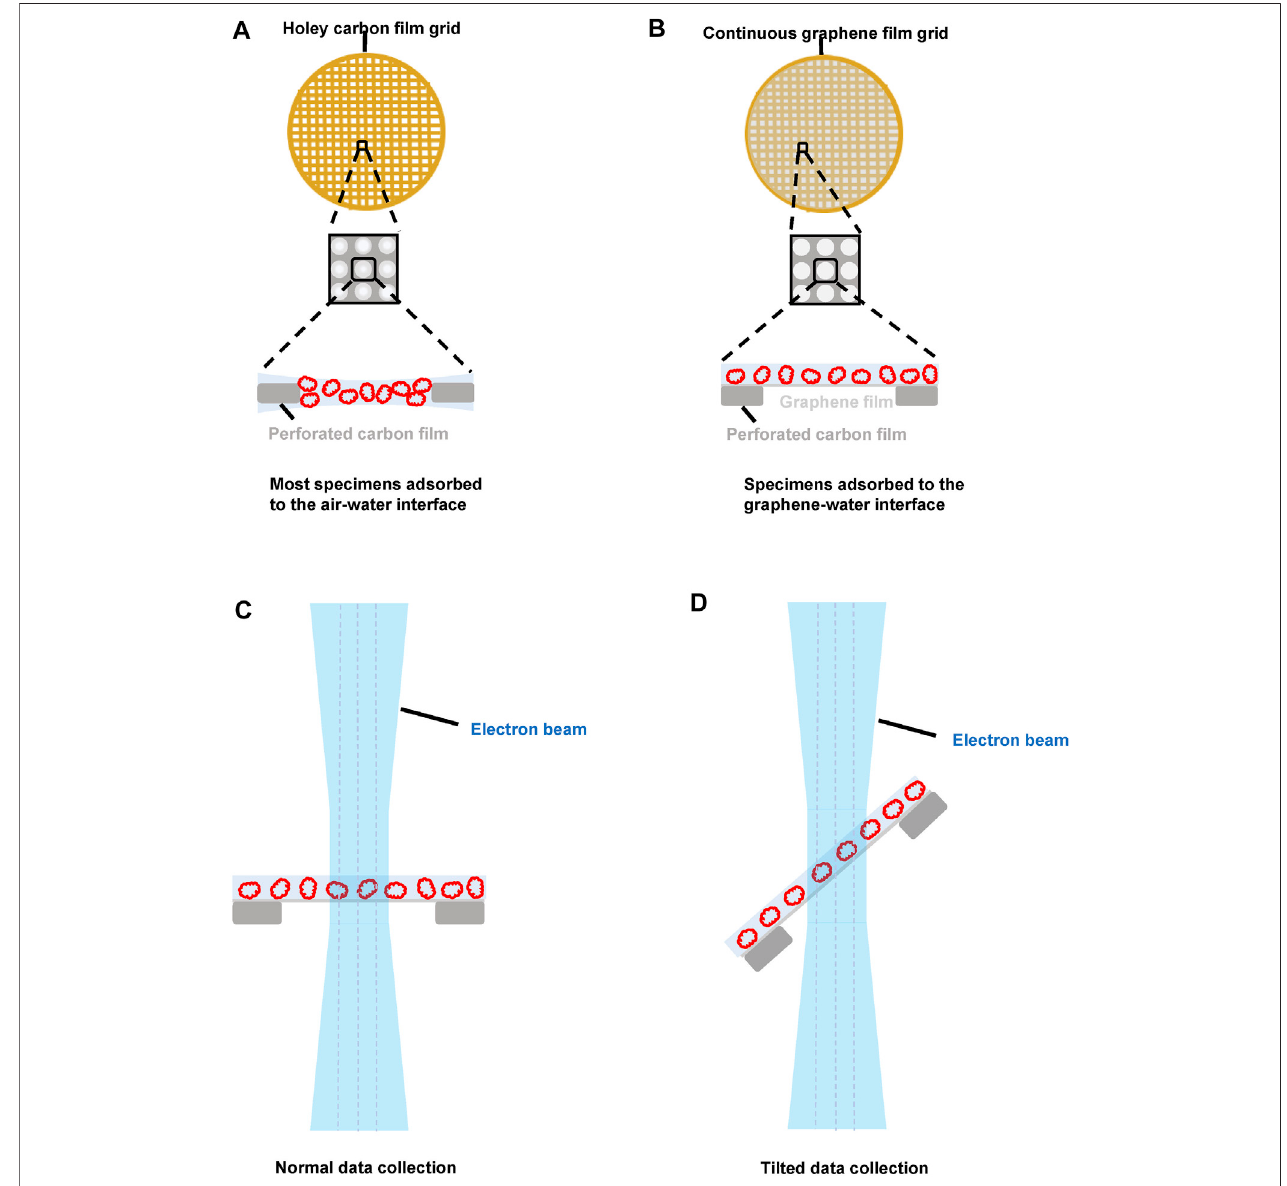
FIGURE 1 | The potential advantages of pristine graphene grids in cryo-EM sample preparation. (A) the sample distribution using the holey carbon grid. Most protein particles are adsorbed onto the air – water interface. (B) the sample distribution using the graphene grid. Due to the interaction between the sample and the graphene – water interface, the protein particles can be kept away from the air – water interface. (C) normal single particle data collection using the graphene grid. The graphene grid can reduce the beam-induced motion. Thin and uniform ice using the graphene grid means that we can choose a smaller defocus without losing contrast.Mostproteinparticlesadsorbedontothegraphenelayerareroughlyinthesameplane,whichmakesthesubsequentcontrasttransferfunctionestimationmore accurate. (D) application of the graphene grid for the tilt data collection strategy, which is a general solution to improve the map quality when the preferential orientation problem occurs (Lyumkis, 2019).